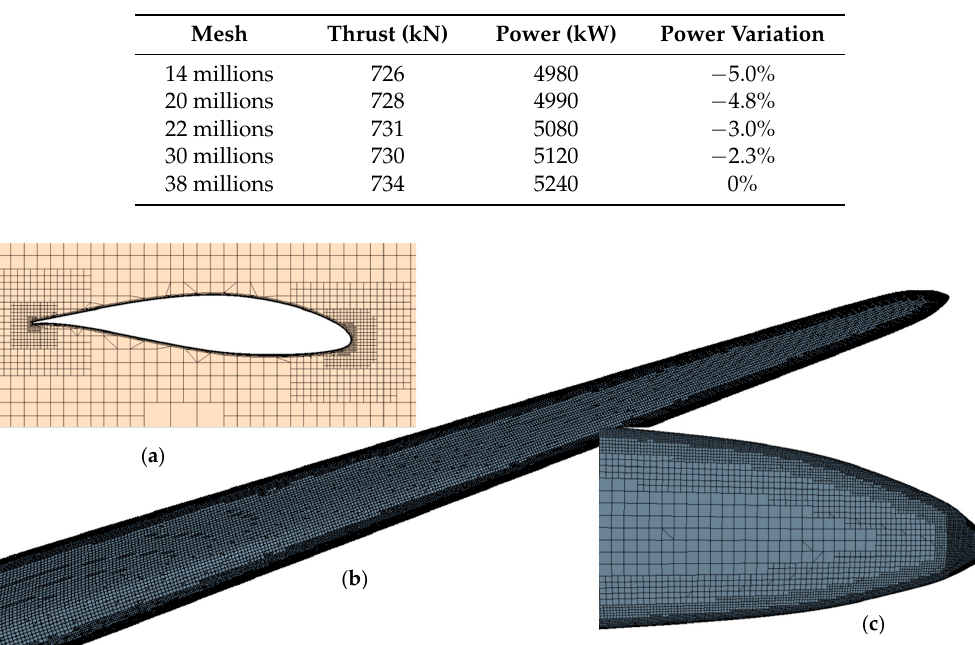
Figure 4. Trim cell detail: ( a ) Mesh section near 45 m spinwise airfoil; ( b ) Trim mesh around blade tip; ( c ) Blade surface mesh.